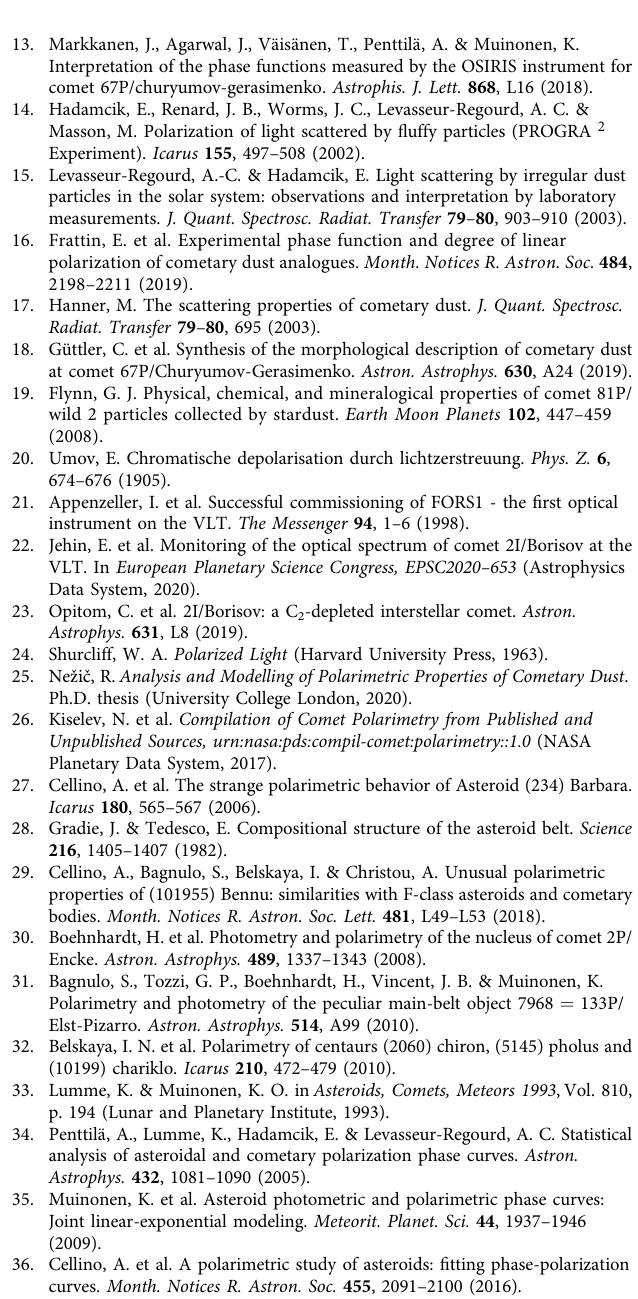
Fig. 6 Residuals of cometary polarisation measurements. Residuals of all comet polarisation measurements (cyan symbols) except those of comet Hale- Bopp fi tted to Eq. (1), compared to our data of comet 2I/Borisov obtained at the largest phase angles (red symbols). Panel a refers to observations obtained in the R F fi lter and panel b to the observations obtained in the I F fi lter. The continuous and dashed curves correspond to statistical prediction bands for 90% and 95% con fi dence respectively. Errorbars are calculated as explained in Methods